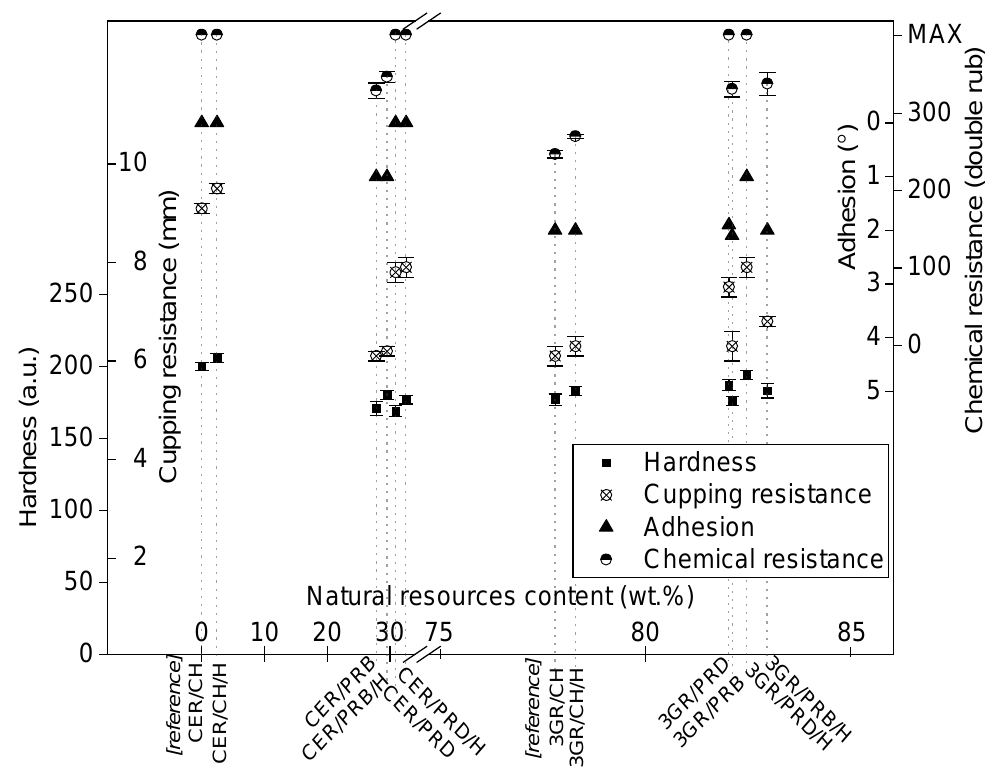
Figure 5. Hardness, cupping resistance, adhesion, and chemical resistance of prepared coatings and reference samples. Symbols are explained in Table 2.